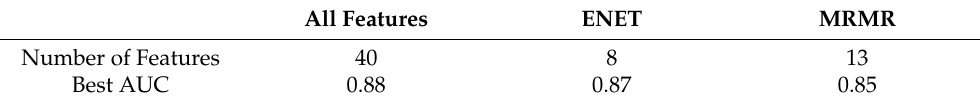
Table 5. Comparison of the number of features selected and performance of ENET and MRMR.